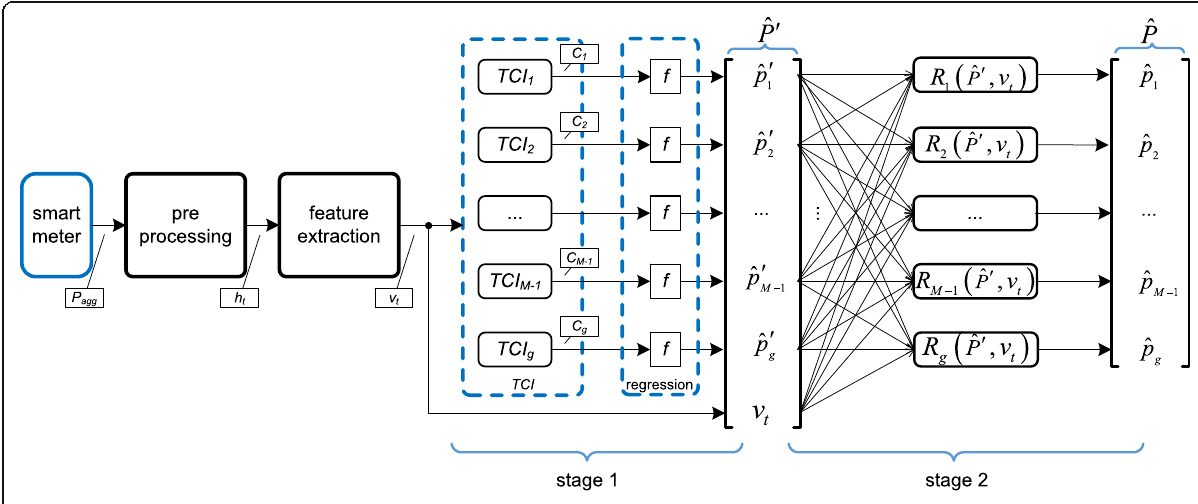
Fig. 2 Block diagram of the NILM architecture using device-dependent temporal contextual information